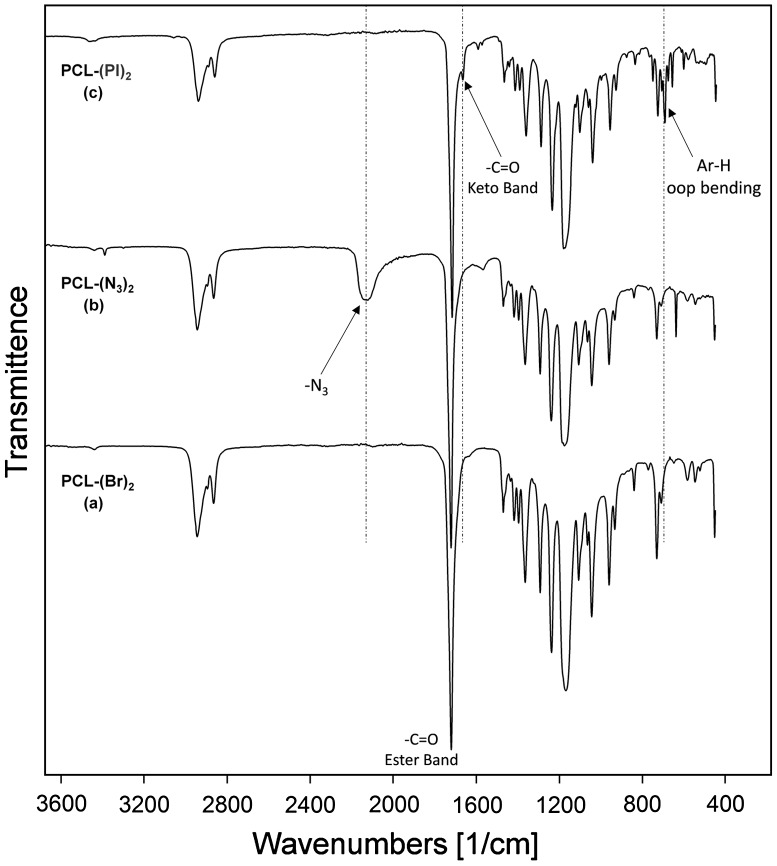
FT-IR spectra of PCL-(Br)2 (a), PCL-(N3)2 (b) and PCL-(PI)2 (c).